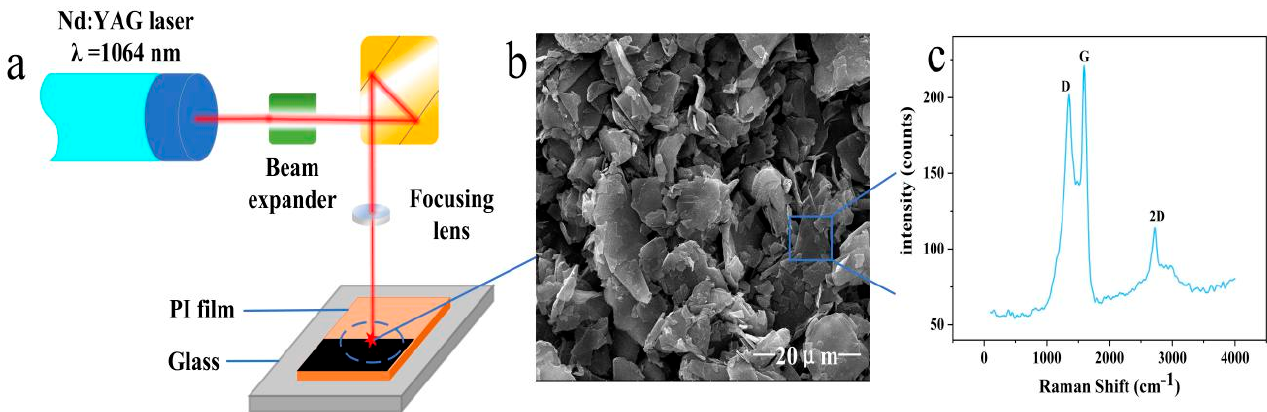
Figure 1. Process to prepare LIG: ( a ) schematic illustration of LIG preparation; ( b ) SEM image of graphene; ( c ) Raman spectrum of graphene.